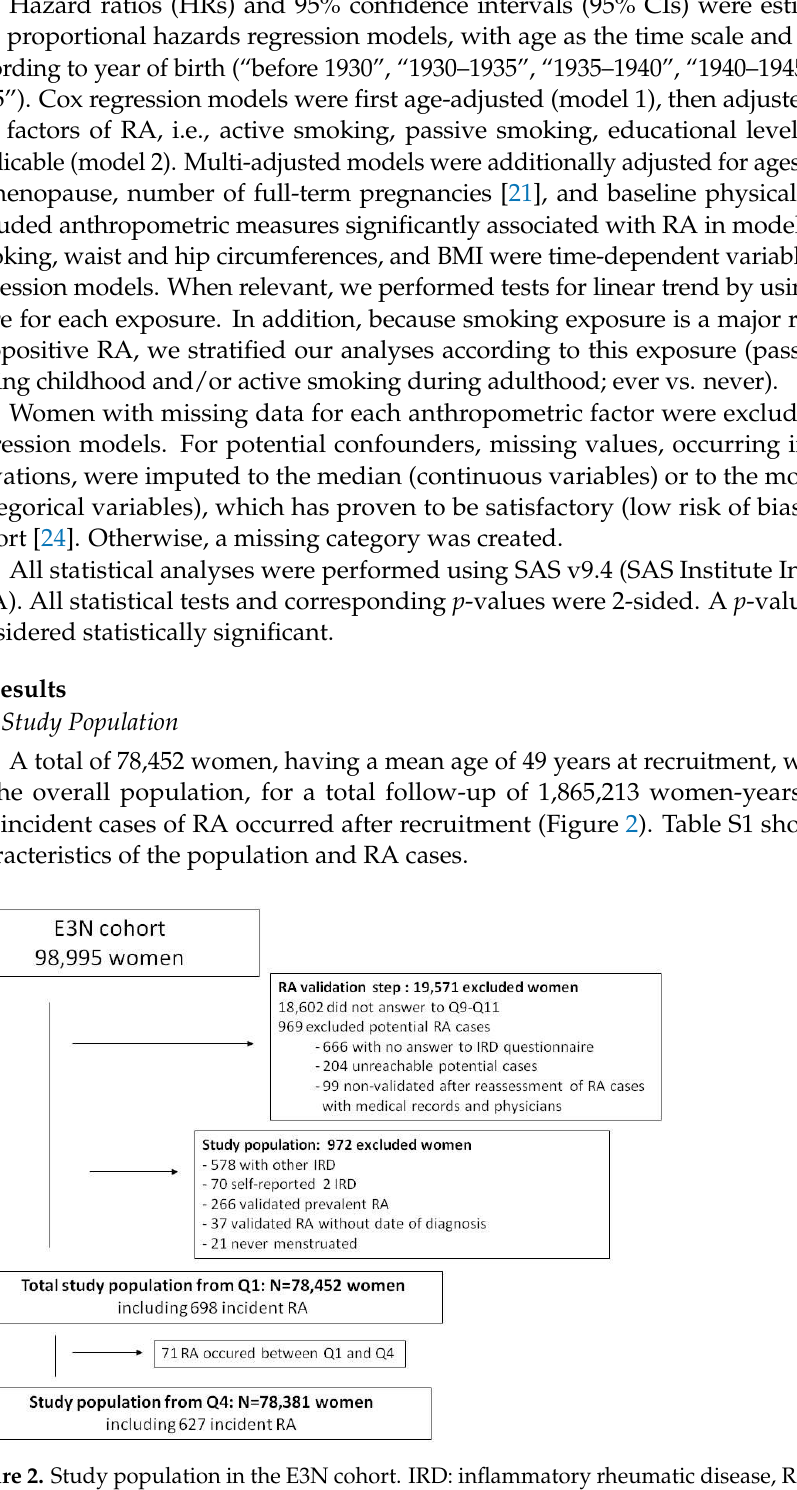
Figure 2. Study population in the E3N cohort. IRD: inflammatory rheumatic disease, RA: rheumatoid arthritis.